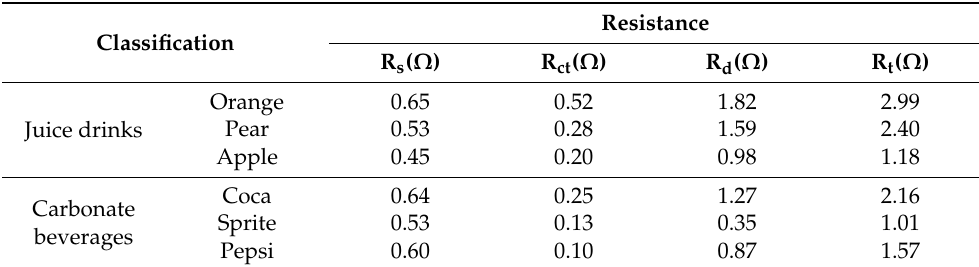
Figure 4. EIS Nyquist plots of the AFC anode with different sweet drinks as substrate ( a ) juice drinks: orange, pear and apple; ( b ) carbonate beverages: Coca, Sprite and Pepsi. Table 4. EIS fitting results of the AFC anode with different sweet drinks as substrate based on the equivalent circuit.